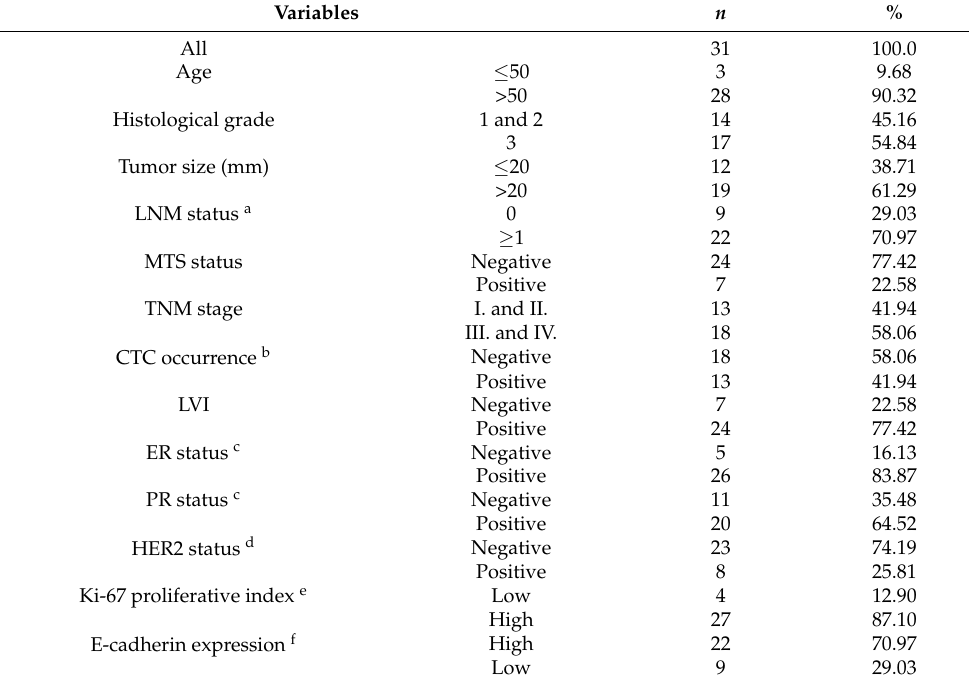
Table 5. Clinical